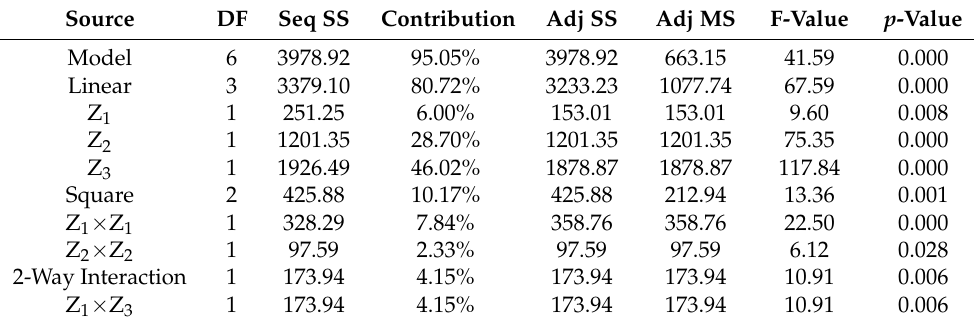
Table 4. Analysis of